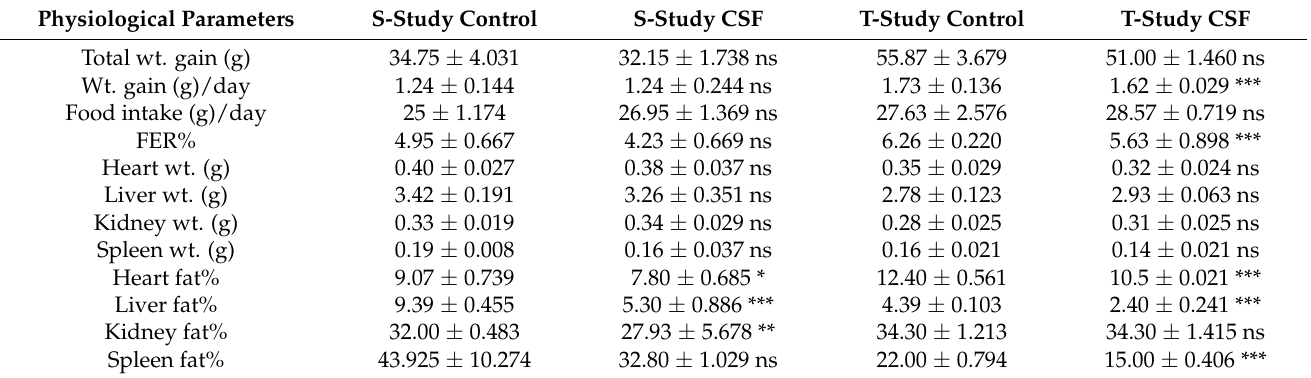
Table 1. Efficacy results (mean ± SD) for physiological parameters of safety and treatment